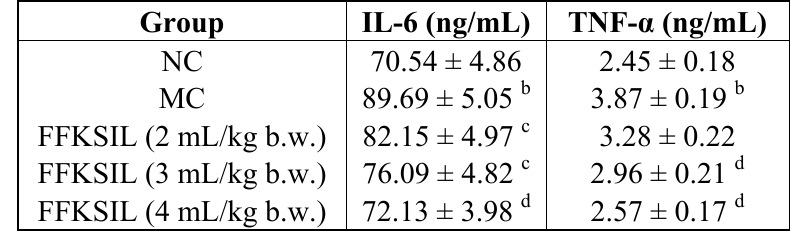
Table 3. Effect of FFKSIL treatment on serum IL-6 and TNF- α levels.